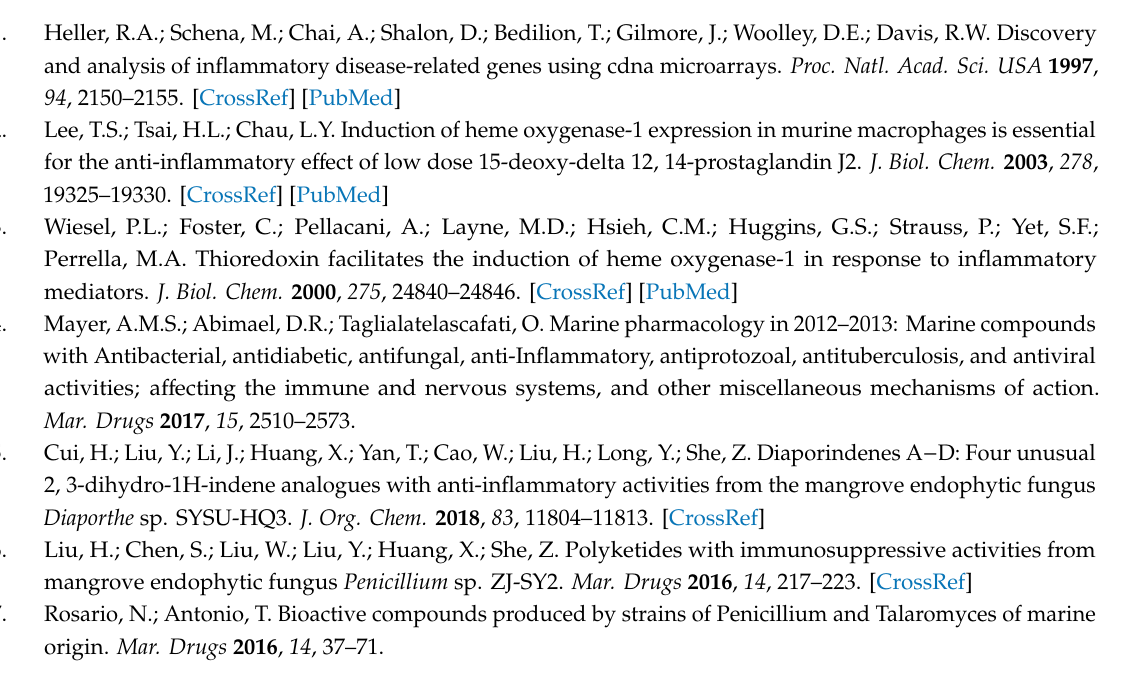
Supplementary Materials: The following are available online, Figures S1–S12: HRESIMS spectrum, 1D- and 2D-NMR spectra of 1 and